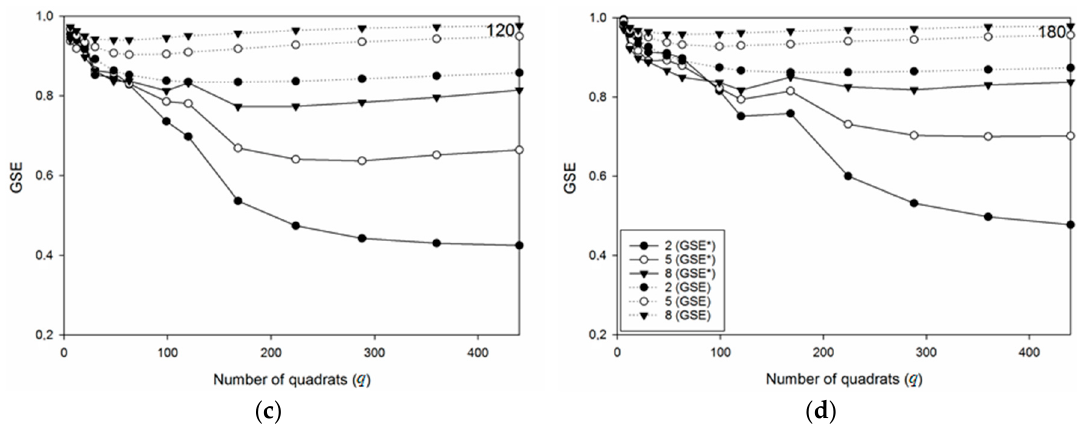
Figure 10. The effect of q on the deviation from CSR. The different graphs represent different degrees of clustering, with σ = 2 being closest to CSR. ( a ) n = 10, ( b ) n = 50, ( c ) n = 120, ( d ) n = 180. Stippled lines: original GSE. Solid lines: modified GSE*.